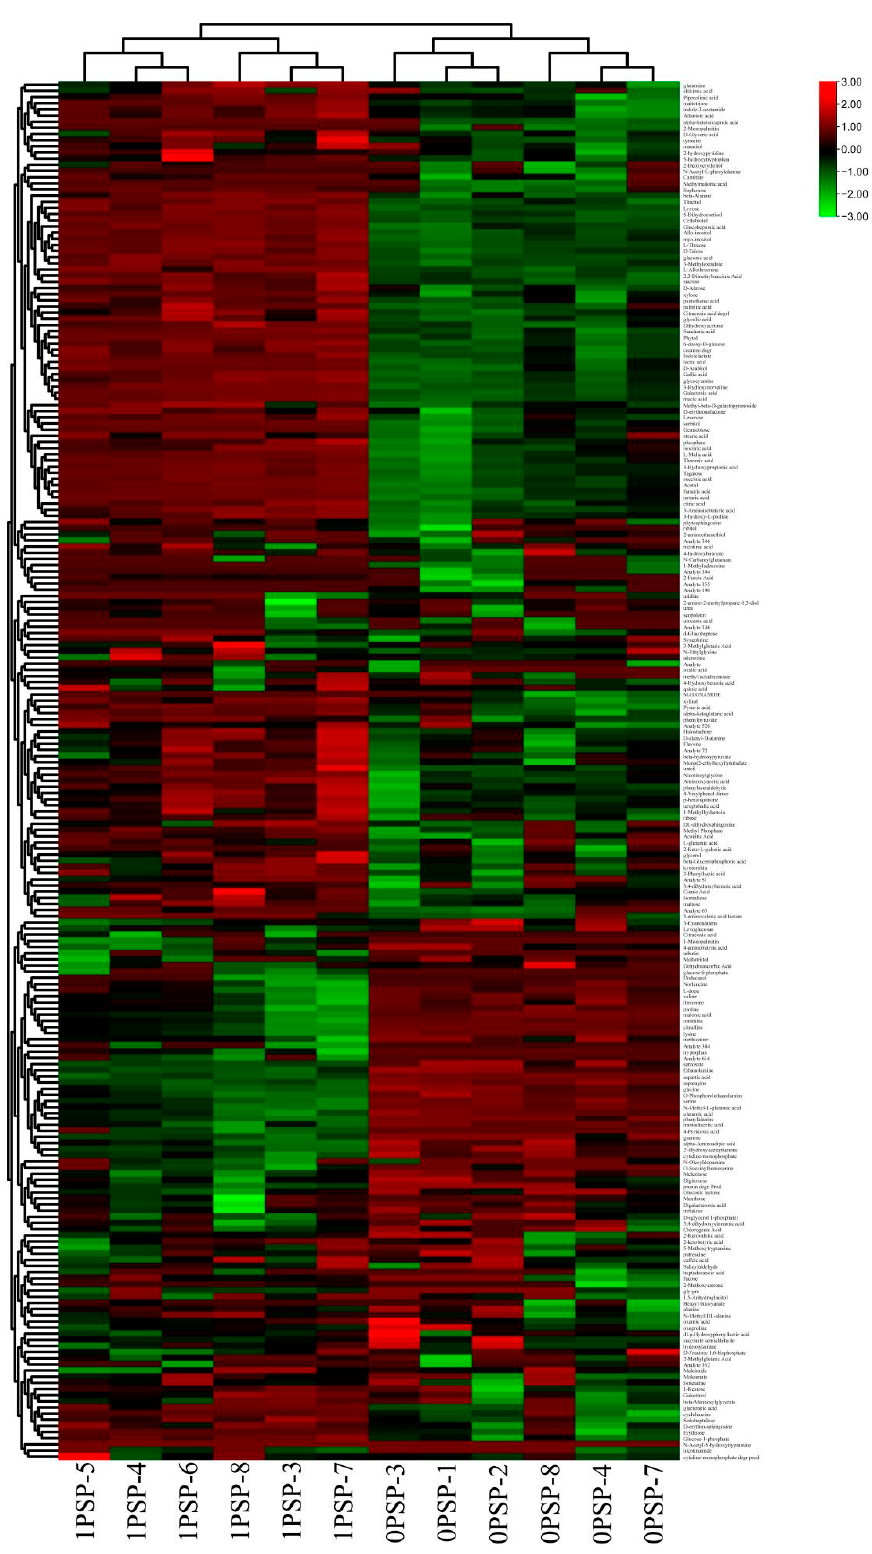
Figure 4. Differential metabolite profiles of purple-fleshed sweet potato storage roots under 60% shading treatment presented in a matrix format. In the matrix, each row represents an individual metabolite. Columns of differential metabolites from purple-fleshed sweet potato storage roots (n = 6, six individual biological samples) represented under 60% shading treatment (1PSP-3, -4, -5, -6, -7 and -8) and nonshaded conditions (0PSP-1, -2, -3, -4, -7 and -8). Red and green reflect relatively upregulated and downregulated metabolites under shading, respectively. Purple-fleshed sweet potato,